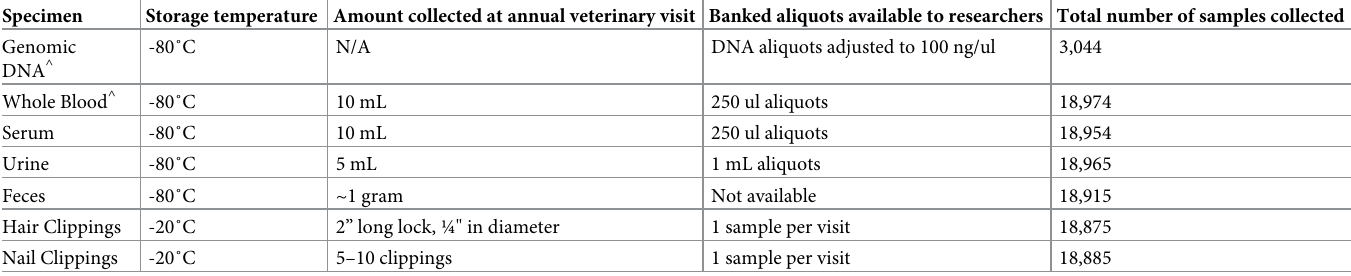
Table 1. Biorepository specimen summary as of May 31, 2021.